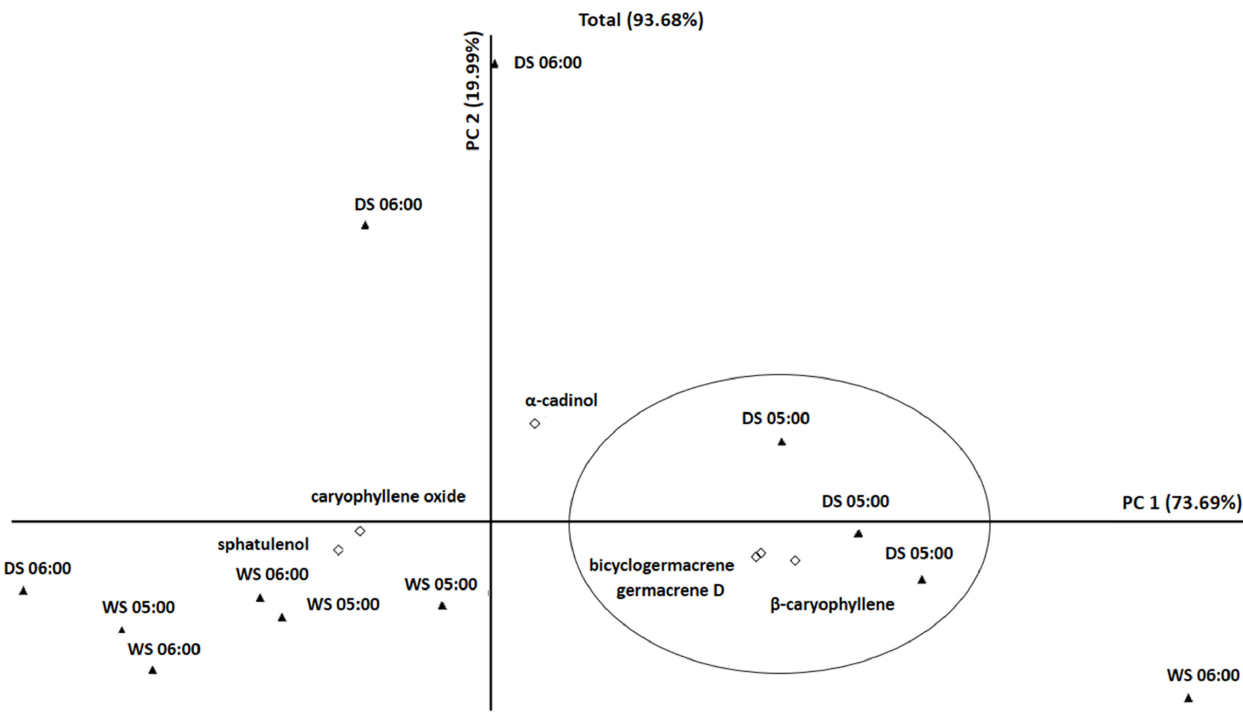
Fig 1. PCA of the main compounds present in the essential oil of Copaifera langsdorffii Desf from a semideciduous seasonal forest at 6:00 am and 5:00 pm during the dry season (DS) and the wet season